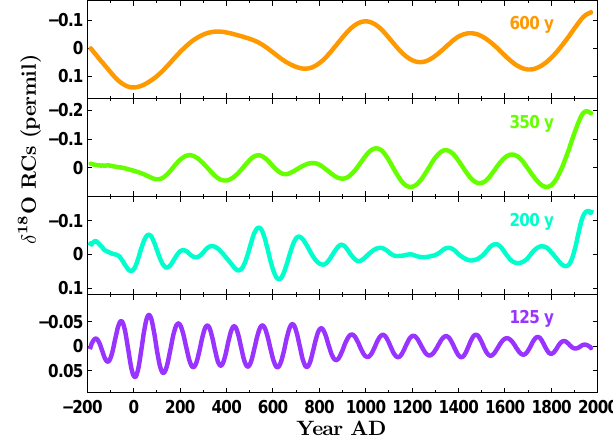
Fig. 1. Time series of δ 18 O from the GT90/3 core and its components. Gray light curve: raw data; black heavy curve: sum of centennial-to-millennial components+ δ 18 O mean value; red heavy curve: trend+ δ 18 O mean value. The δ 18 O-axis is reversed, here and in subsequent figures, to agree in tendency with temperature. The SSA results plotted here correspond to a window width of M ≈ 600 yr; they have been shown to be significant at the 99% level and robust for a wide range of window widths by Taricco et al. (2009).